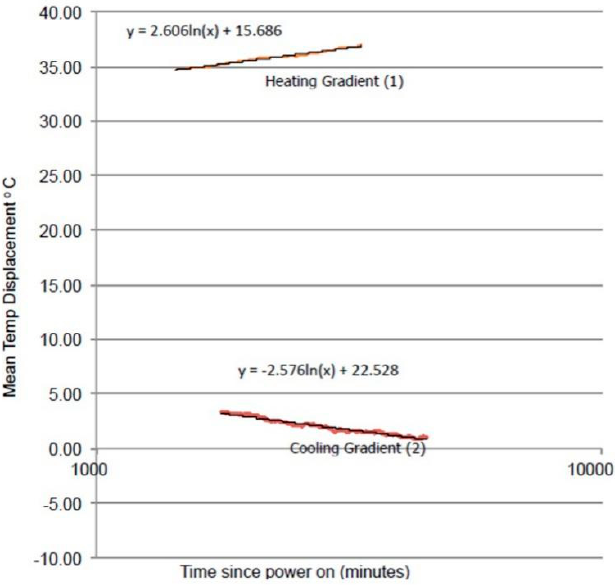
Figure 6. Thermal Response Test (TRT) data recording for the Shell Centre energy pile.